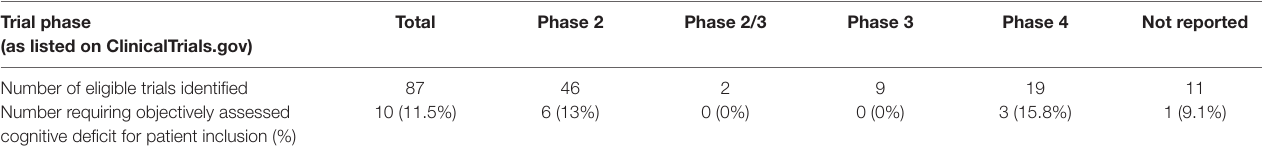
TABLE 1 | Eligible CIAS pharmacotherapy trials that listed an objectively measured cognitive deficit among their patient inclusion criteria. Trial phase (as listed on